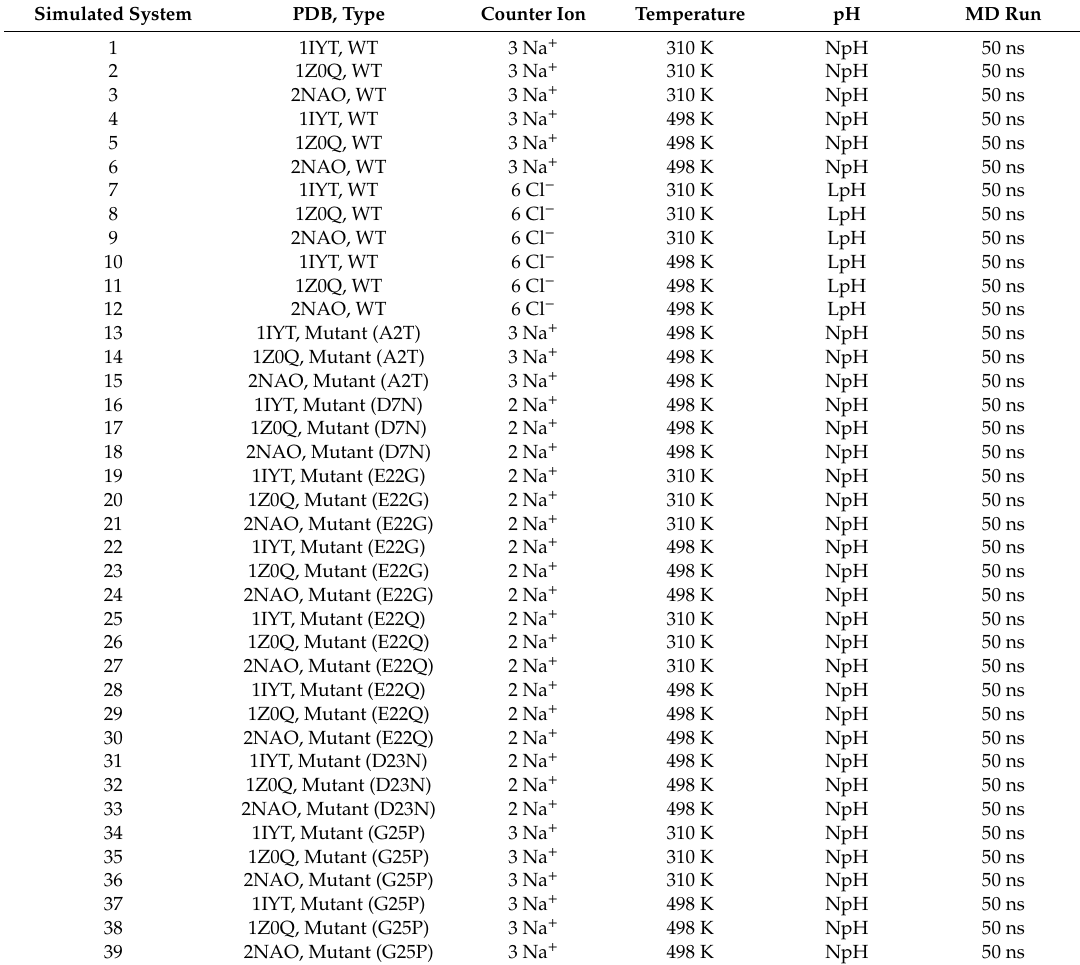
Table 1. MD simulations performed in the present study. Aggregated simulation time is 1950